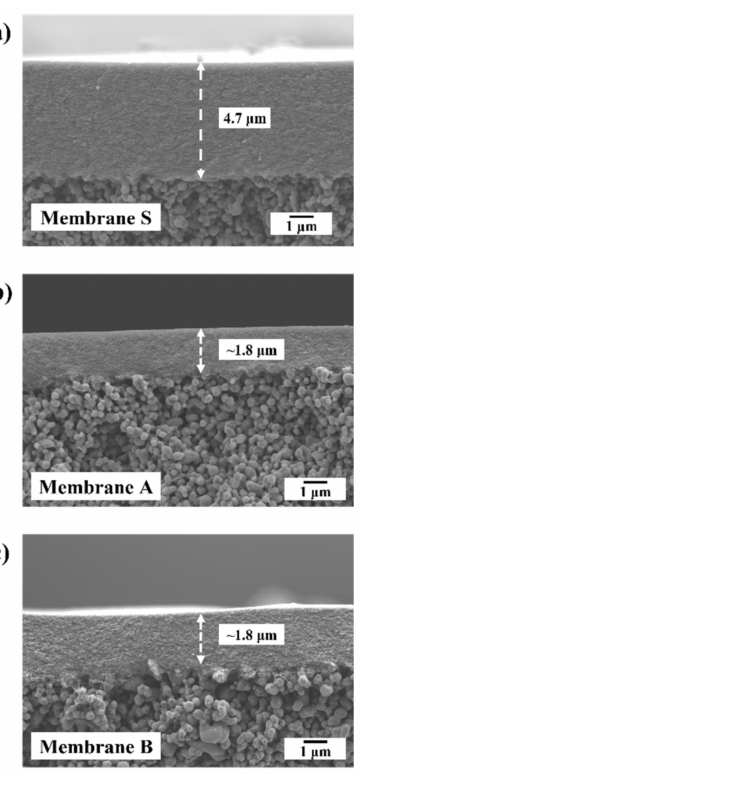
Figure 2. Top surface SEM micrographs of γ -Al 2 O 3 tight ultrafiltration (UF) membranes: ( a ) mem- brane S (without the addition of PVA); ( b ) membrane A (addition of PVA after peptization); and ( c ) membrane B (addition of PVA before